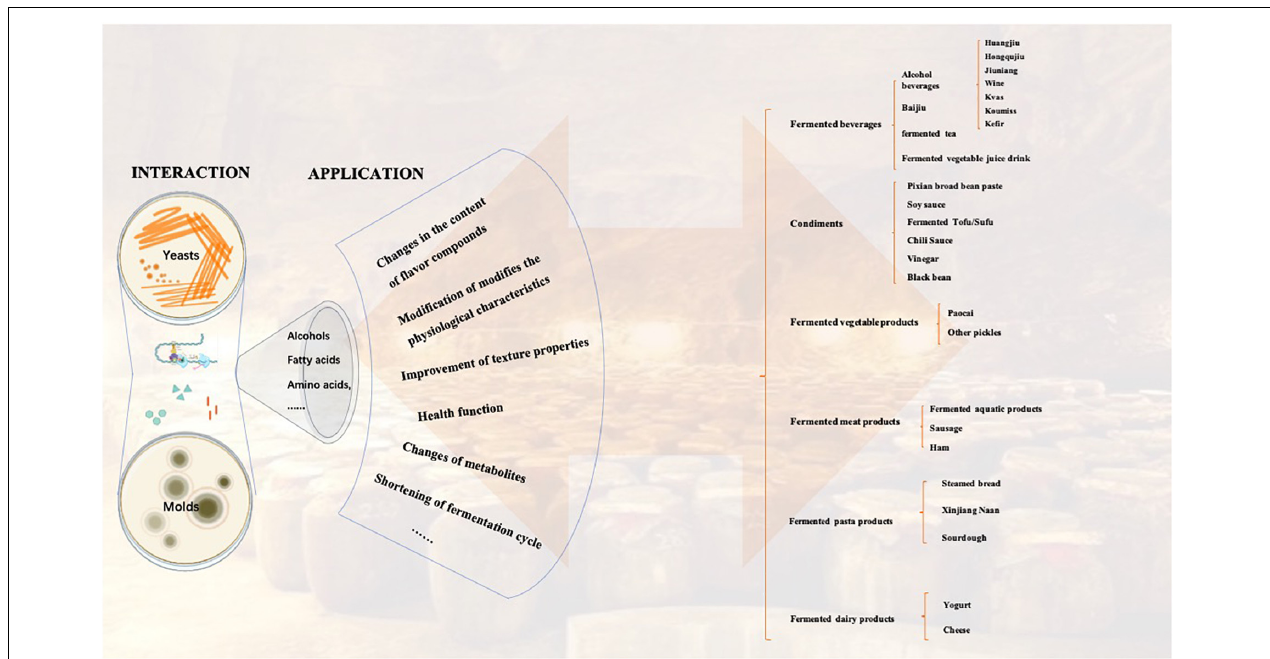
FIGURE 1 | Distribution and classification of traditional fermented foods in